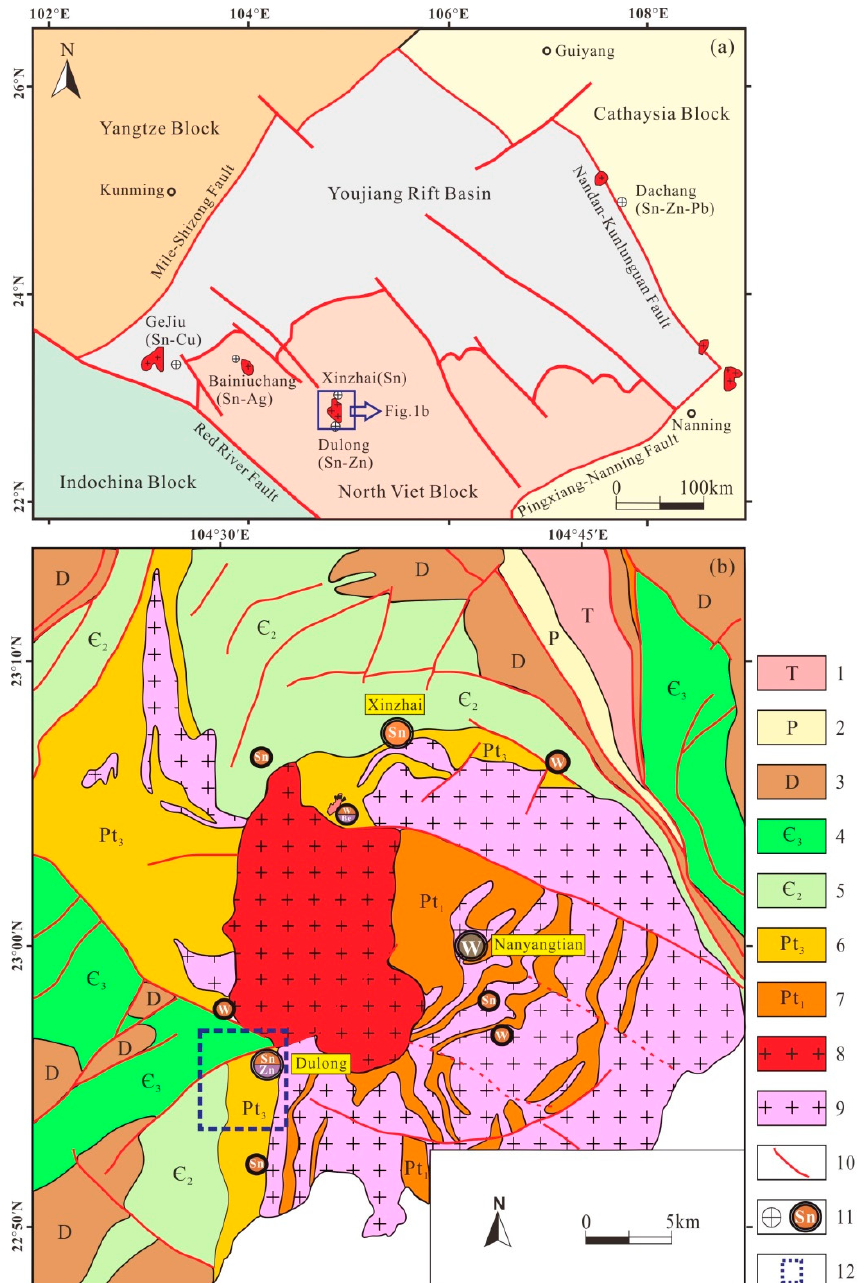
Figure 1. Geotectonic location and regional geological map (modified using Ref. [23]). ( a ) The geotectonic location of the Dulong Sn-Zn polymetallic deposit; ( b ) The regional geological map of the Dulong Sn-Zn polymetallic deposit. 1—Triassic mudstone and tuff; 2—Permian siliceous rocks and mudstones; 3—Devonian carbonate rocks; 4—Upper Cambrian dolomite and limestone; 5—Middle Cambrian dolomite and phyllite; 6—Upper Proterozoic marble and schist; 7—Lower Proterozoic schist and granulite; 8—Cretaceous granite; 9—Silurian gneiss granite; 10—fault; 11—deposit; 12—3D geological modeling area.